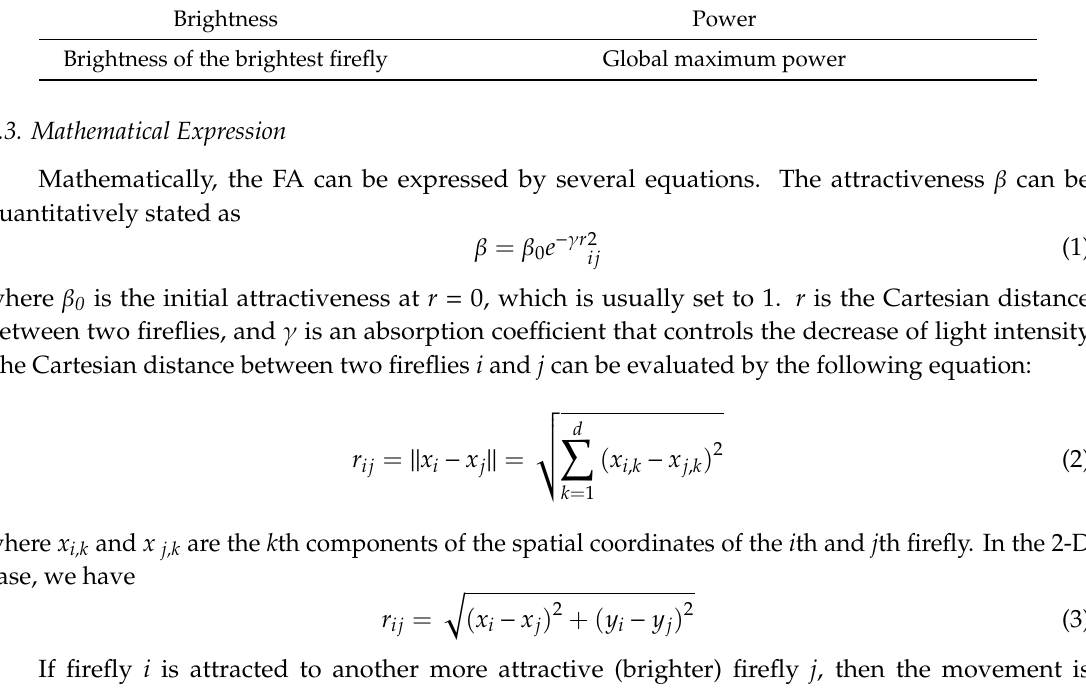
Table 1. Terminologies of Firefly Algorithm (FA) and photovoltaic (PV) system. Firefly Algorithm PV System Firefly position Two-dimensional coordinates expressed as (Voltage, Power) Distance Cartesian distance between firefly positions